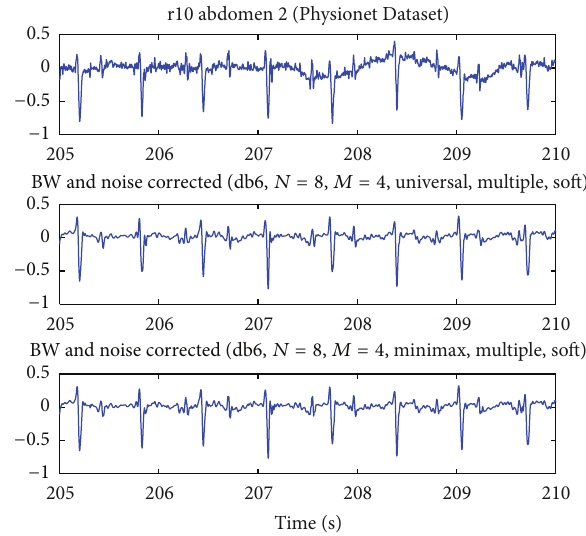
Figure 12: r10 abdomen 2 Abdominal and Direct Fetal Electrocar- diogram Database (Physionet Dataset) signal and BW and noise corrected signals using two types of